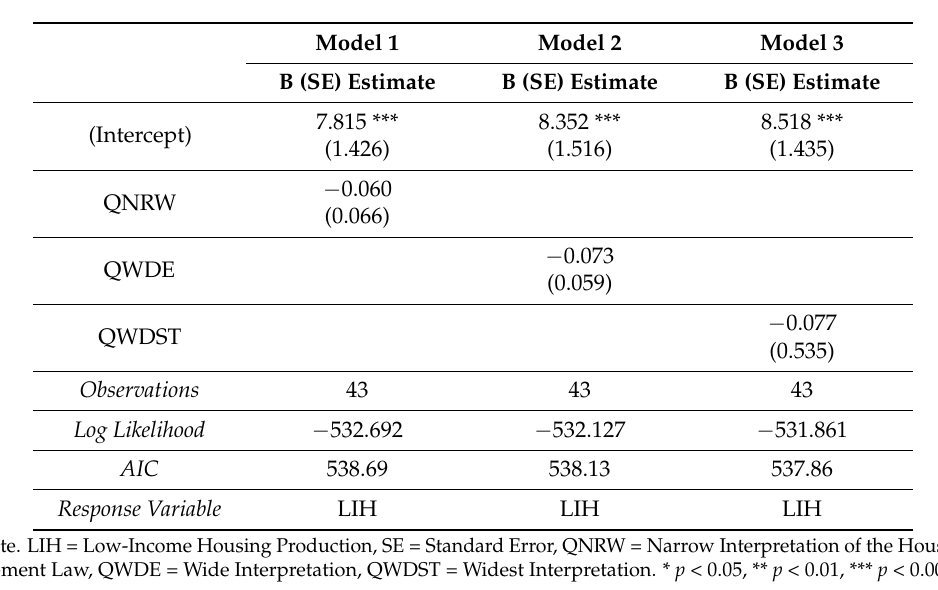
Table A5. The negative binomial tests.